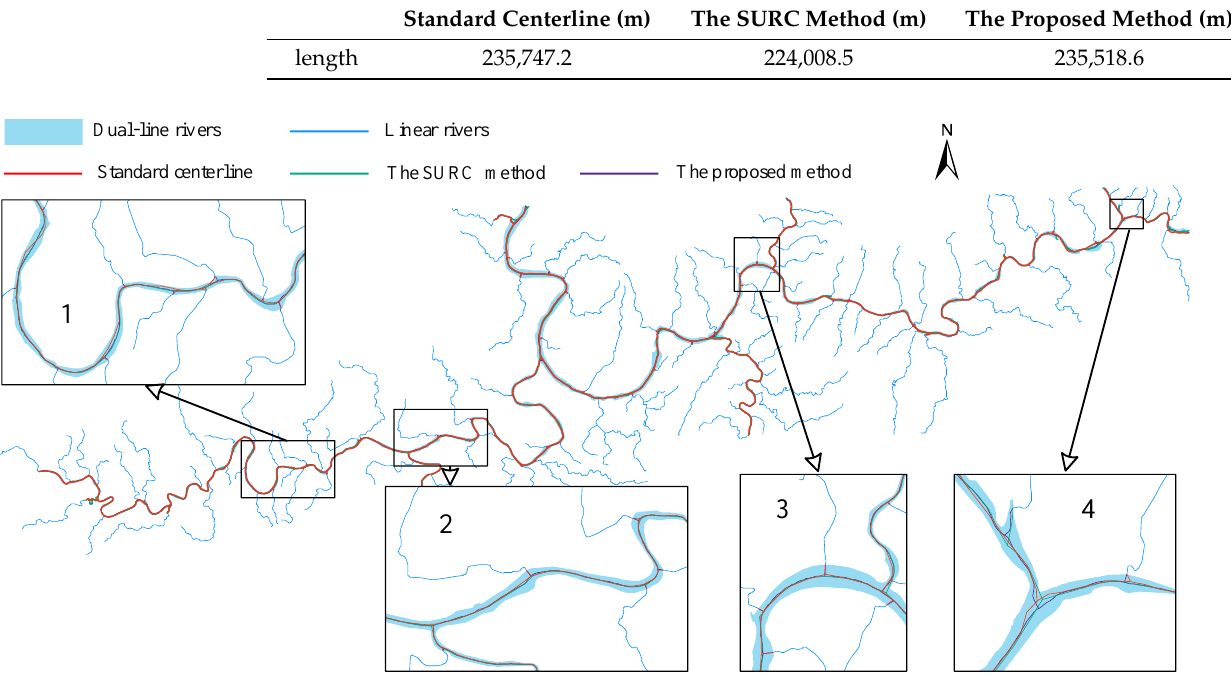
Table 4. Length of the skeleton lines extracted by the two methods.